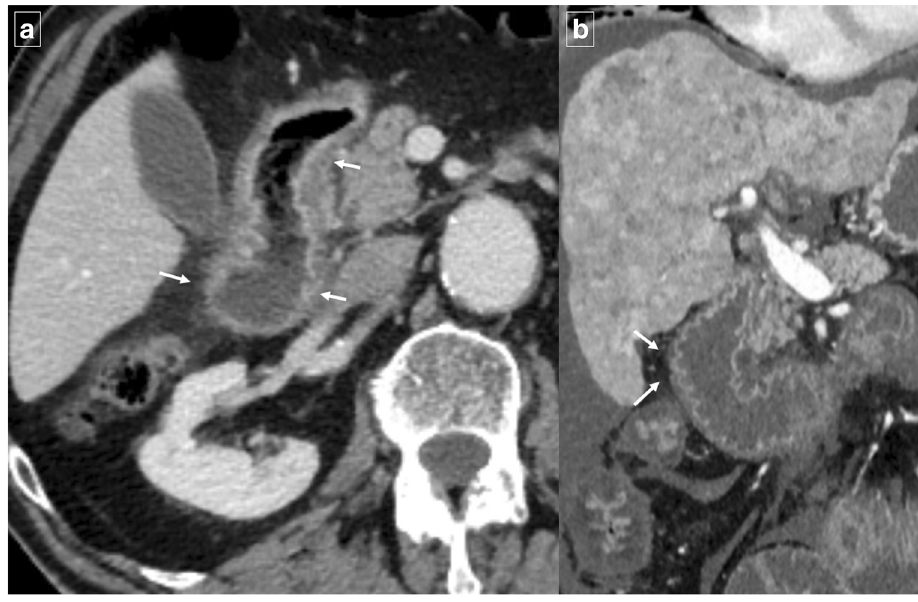
Fig. 8 Spectrum of duodenitis in different patients. a Axial contrast-enhanced CT shows thickened oedematous duodenal wall with inflammation involving periduodenal fat (arrows) in nonspecific duodenitis. b Reformatted coronal contrast- enhanced CT image in a woman with disseminated breast cancer and secondary hepatic insufficiency shows nonspecific mural thickening of the duodenum with mucosal enhancement (arrows)